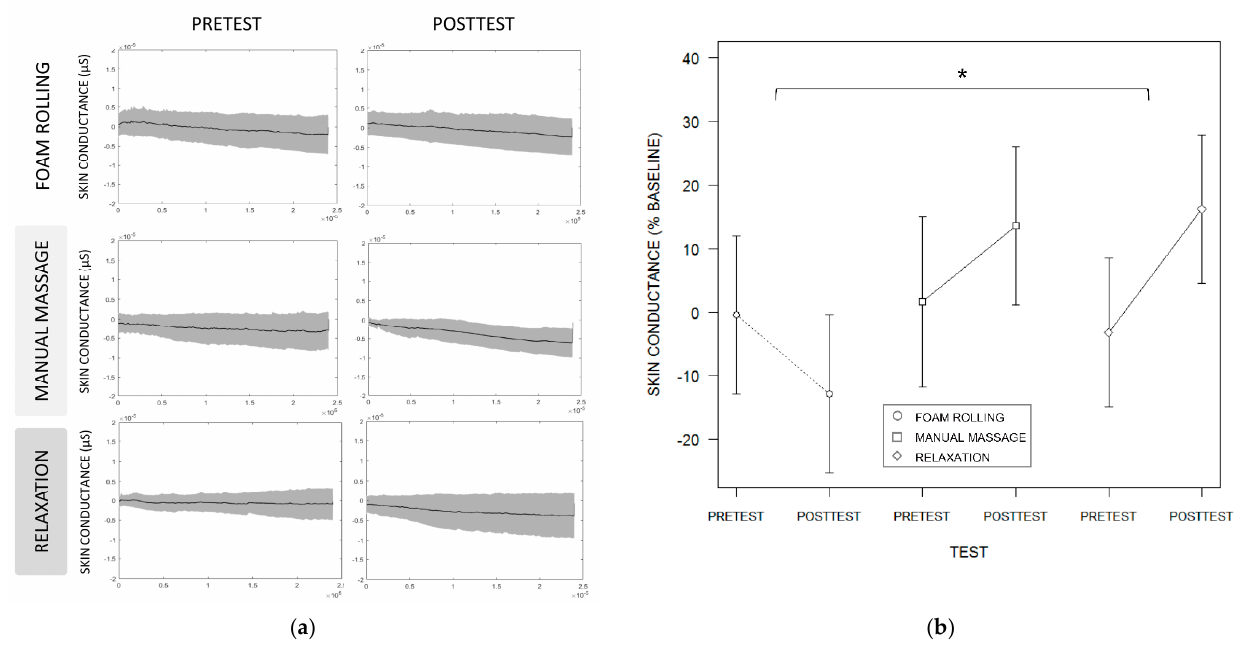
Figure 5. ( a ) Group average (SD) for the time course of skin conductance values during the pretest and posttest resting-state recordings; ( b ) fitted values revealed by the linear mixed effects analysis for the TEST × GROUP interaction on skin conductance, represented with their 95% confidence intervals (error bars). * p < 0.05.